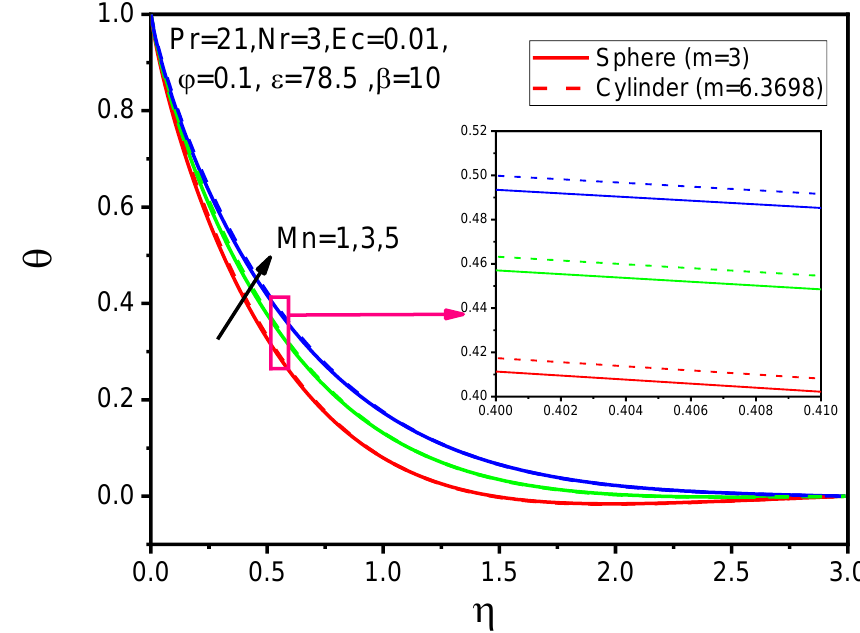
' F for 5,3,1 = Mn against